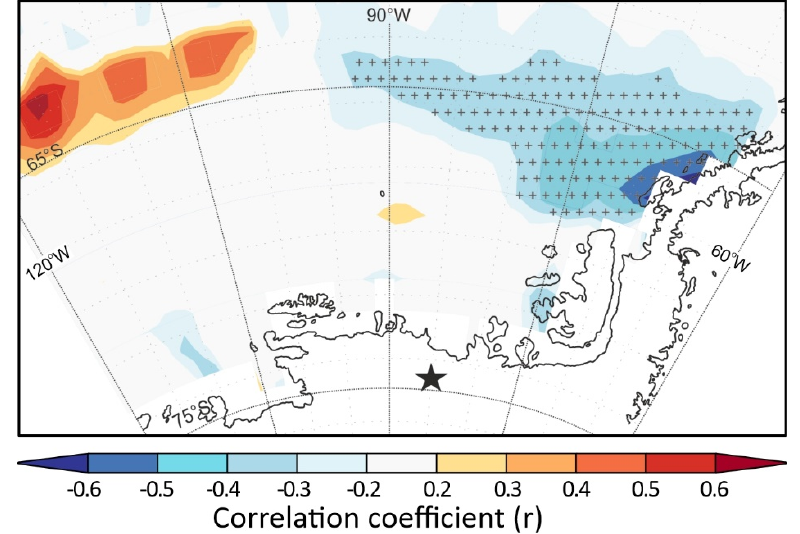
Figure 9. Correlation (detrended) of calibrated diatom flux (n m − 2 a − 1 ) with winter (August–October) sea-ice concentration 1980–2010. Hatching indicates region of significant ( p < 5%) negative correlation (max r = − 0.6); black star indicates the location of the Ferrigno ice core; sea ice area mapped from ERA-Interim grid at lower resolution than AP coastline and the area shown in the figure lies within the demarcation of the Amundsen and Bellingshausen Seas given in Figure 1.